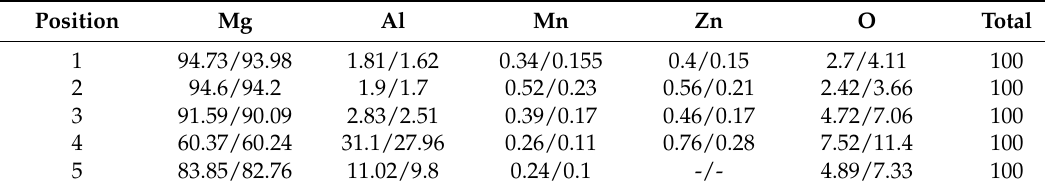
Table 1. EDS analysis on different position of rheo-diecasted AM60 (wt. %/at. %).